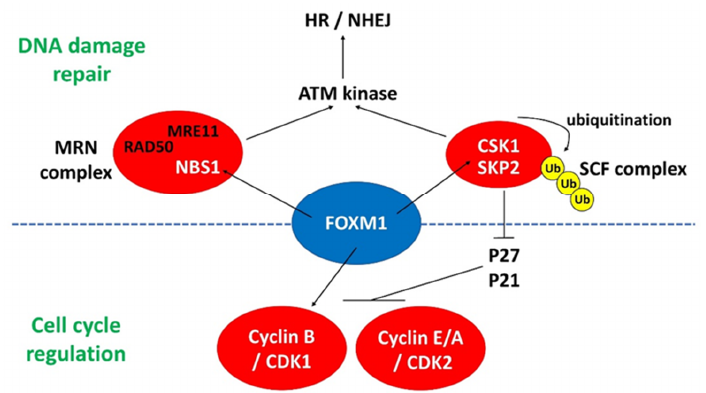
Figure 1. The interactions of FOXM1 with different regulators involved in DNA damage repair and cell cycle progression. MRN complex: MRE11/RAD50/NBS1; HR: homologous recombination; NHEJ: non-homologous end joining; Ub: ubiquitination.